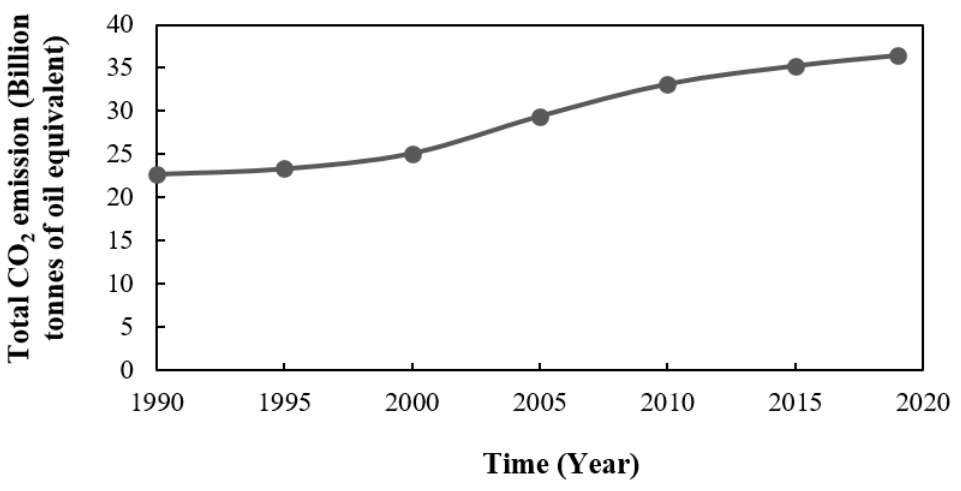
Figure 2. World’s total CO 2 emissions from 1990 to 2019 [3].